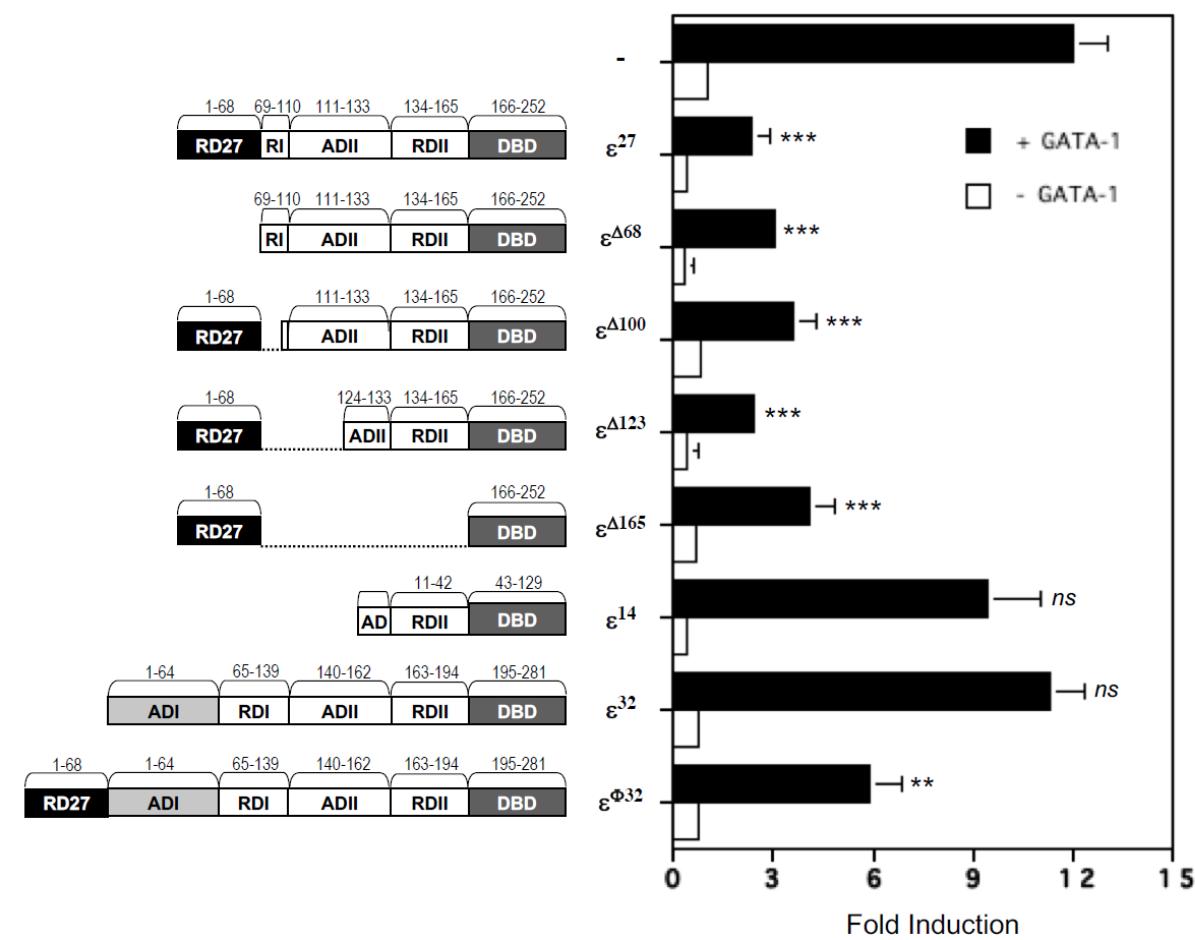
Figure 5. Mutational analyses of C/EBP ε 27 demonstrate that both its unique 68 amino acid N-terminal (RD27) and RDI domains are required for repression of GATA-1 activity for the MBP1-P2 promoter. The cartoons to the left show the unique N-terminal (RD27) and previously mapped repressor (RDI, RDII) and activation (ADI, ADII) domains shared amongst the various C/EBP ε isoforms. Regions removed in the various deletion mutants and added in the fusion proteins are indicated. The DNA-binding domain (DBD) includes both the basic region (BR) and leucine zipper dimerization domain. Both the previously described RDI repression domain of C/EBP ε 32 (amino acids 64–129) for which its core sequence (amino acids 68–100) is conserved in the C/EBP ε 27 isoform, and the RD27 domain (distinct N-terminal 68 amino acids of C/EBP ε 27 ) contribute to C/EBP ε 27 antagonism of GATA-1 activity in transactivation assays of the MBP P2 promoter performed in CV-1 cells in the presence or absence of co-transfection with the GATA-1 expression vector. Both the 2 – 68 and 69-165 deletion mutants of C/EBP ε 27 retain their full inhibitory activity in co-transfections with GATA-1 compared to full length C/EBP ε 32 , C/EBP ε 27 , and C/EBP ε 14 . The 69 – 100, 69 – 123, and 69 – 165 deletion mutants of C/EBP ε 27 retain their repressor activity even though the core/complete RDI domain of wild type C/EBP ε 27 , including the sumoylation (SUMO) consensus site (amino acids 91 – 95 in C/EBP ε 27 ) is absent. Fusion of the unique RD27 domain to full length C/EBP ε 32 ( ε φ 32 ) converts it into a partial repressor of GATA-1. *** p < 0.001; ** p < 0.01; ns , not significant, compared to GATA-1 alone.